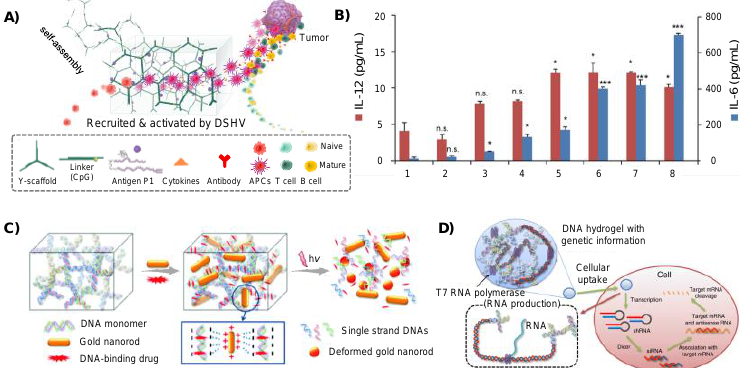
Figure 2. Branched DNA formed hydrogels for cancer therapy: ( A ) The recruitment and activation of APCs by the DNA supramolecular hydrogel vaccine (DSHV) system. ( B ) Different samples stimulated APCs to produce IL-6 and IL-12. Reproduced with permission. *p < 0.05, ***p < 0.001. n.s. = not significant. Copyright 2018 [46], the American Chemical Society. ( C ) DNA hydrogel incorporated with gold nanorod for cancer drug delivery. Reproduced with permission. Copyright 2015 [48], Royal Society of Chemistry. ( D ) Schematic illustration of RNA interference (RNAi) caused by RNAi-exhibiting gel (I-gel) in living cells. Reproduced with permission. Copyright 2018 [47], Springer Nature.